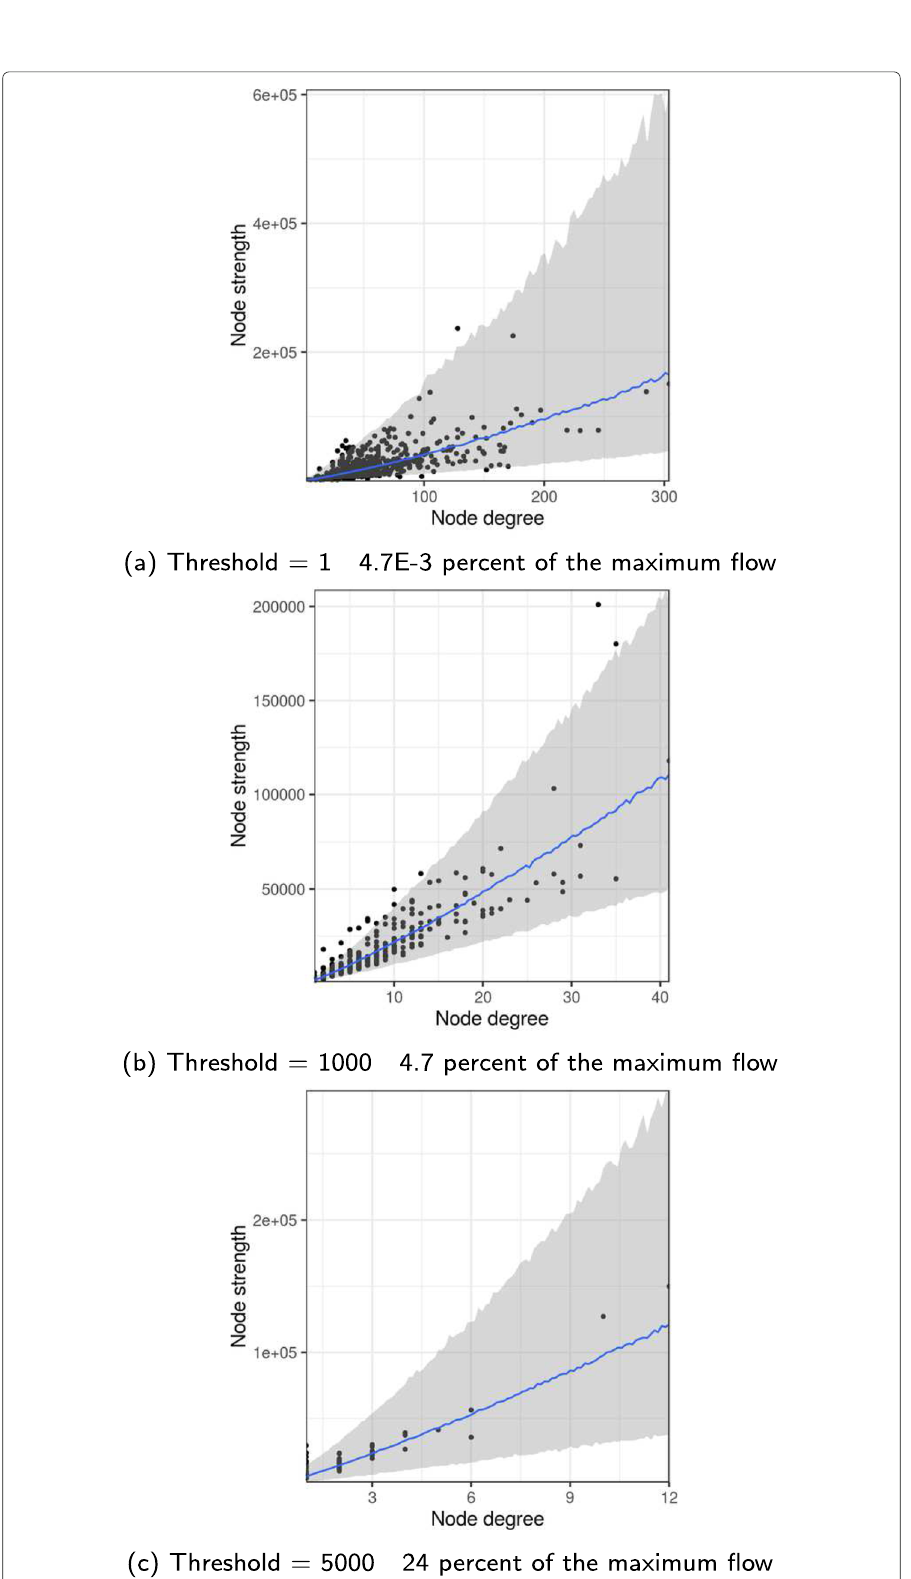
Fig. 2 Fitted regression lines and 95% prediction intervals for power law regression of weight versus degree. We present results for each threshold. a ) Threshold = 1 (4.7E-3 percent of the maximum flow), b ) Threshold = 1000 (4.7 percent of the maximum flow), c ) Threshold = 5000 (24 percent of the maximum